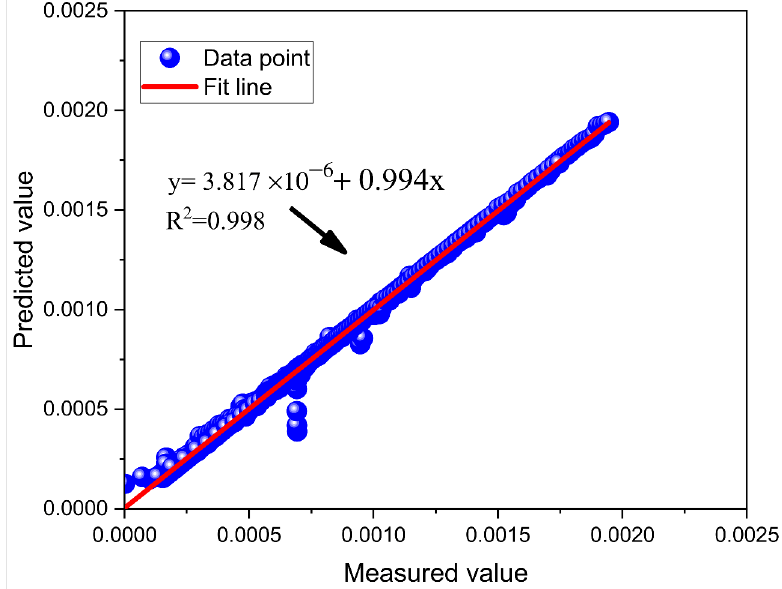
Figure 20. Relationship between predicted and measured values using